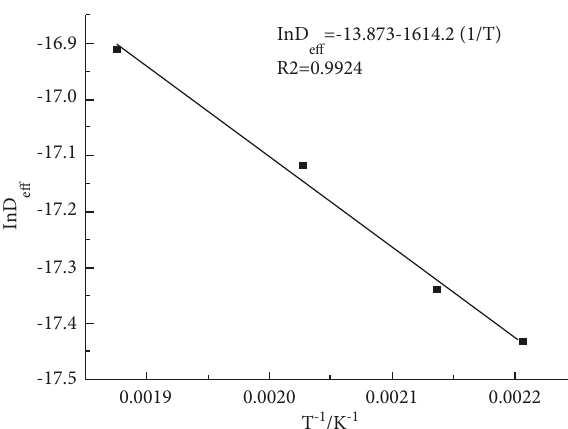
Figure 7: Fitting results between ln D eff and 1/ T under different steam temperatures with sludge thickness of 6mm and steam flow of 22 m 3